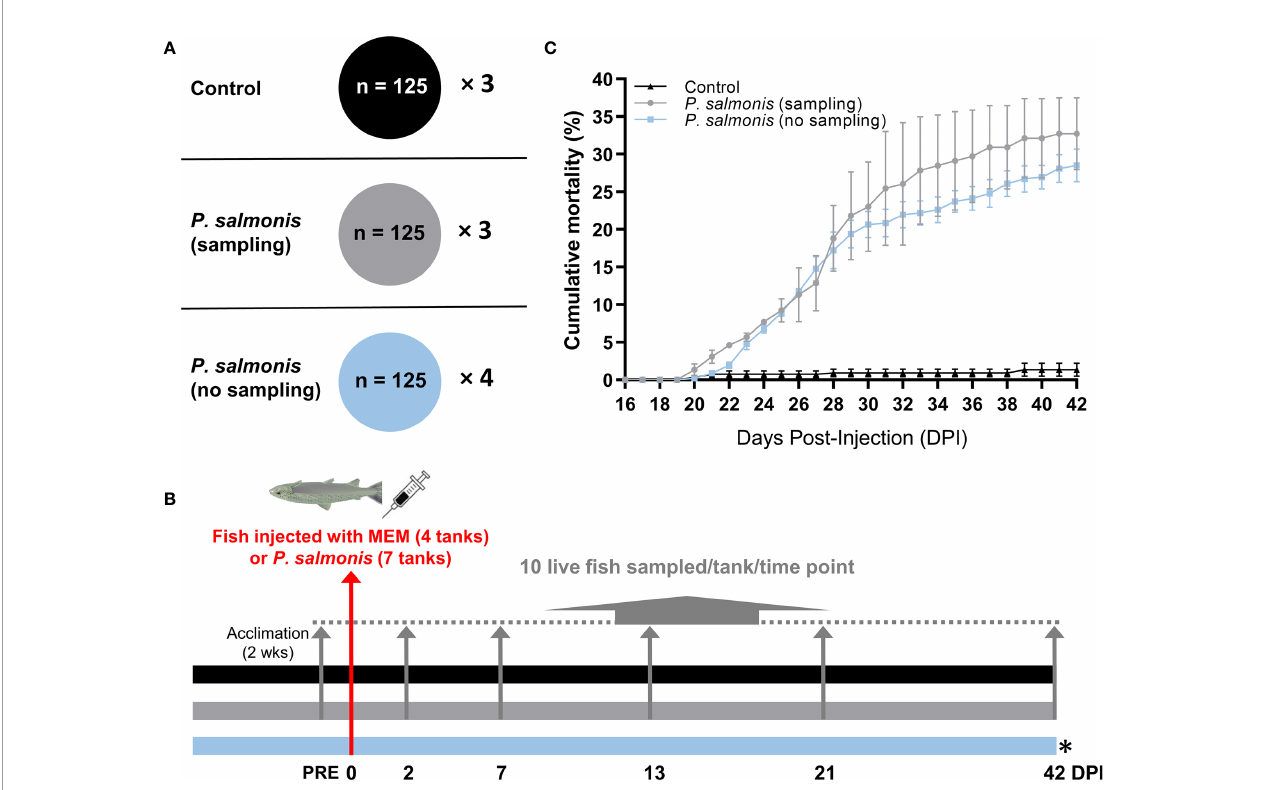
FIGURE 1 | Overview of the infection trial, sampling and cumulative mortality. (A) The tank allocation and the number of fi sh for each treatment group [Control (MEM media injected), P. salmonis- injected (sampling), P. salmonis -injected (no sampling)]. (B) Timeline of the overall study with sampling regime showing the number of days post-infection (DPI). Four out of 7 tanks in the challenge group [i.e. P. salmonis -injected (no sampling)] were left untouched in order to monitor mortality. (C) Cumulative mortality in each treatment group. No statistical signi fi cance was found in the cumulative mortality by the end of the infection trial between P. salmonis -injected (sampling) and P. salmonis -injected (no sampling) groups ( p > 0.05; Student ’ s t